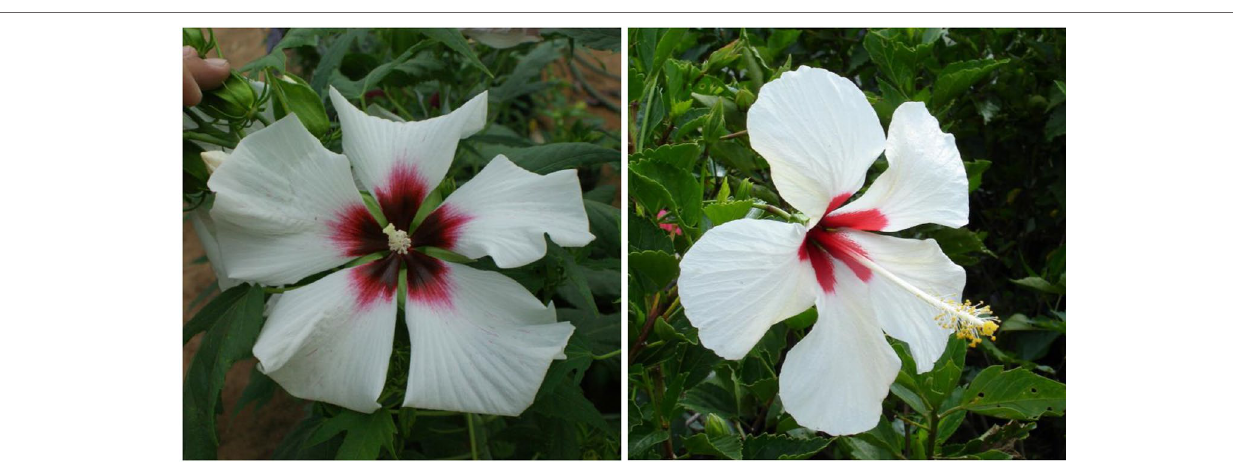
Frontiers in Plant Science |